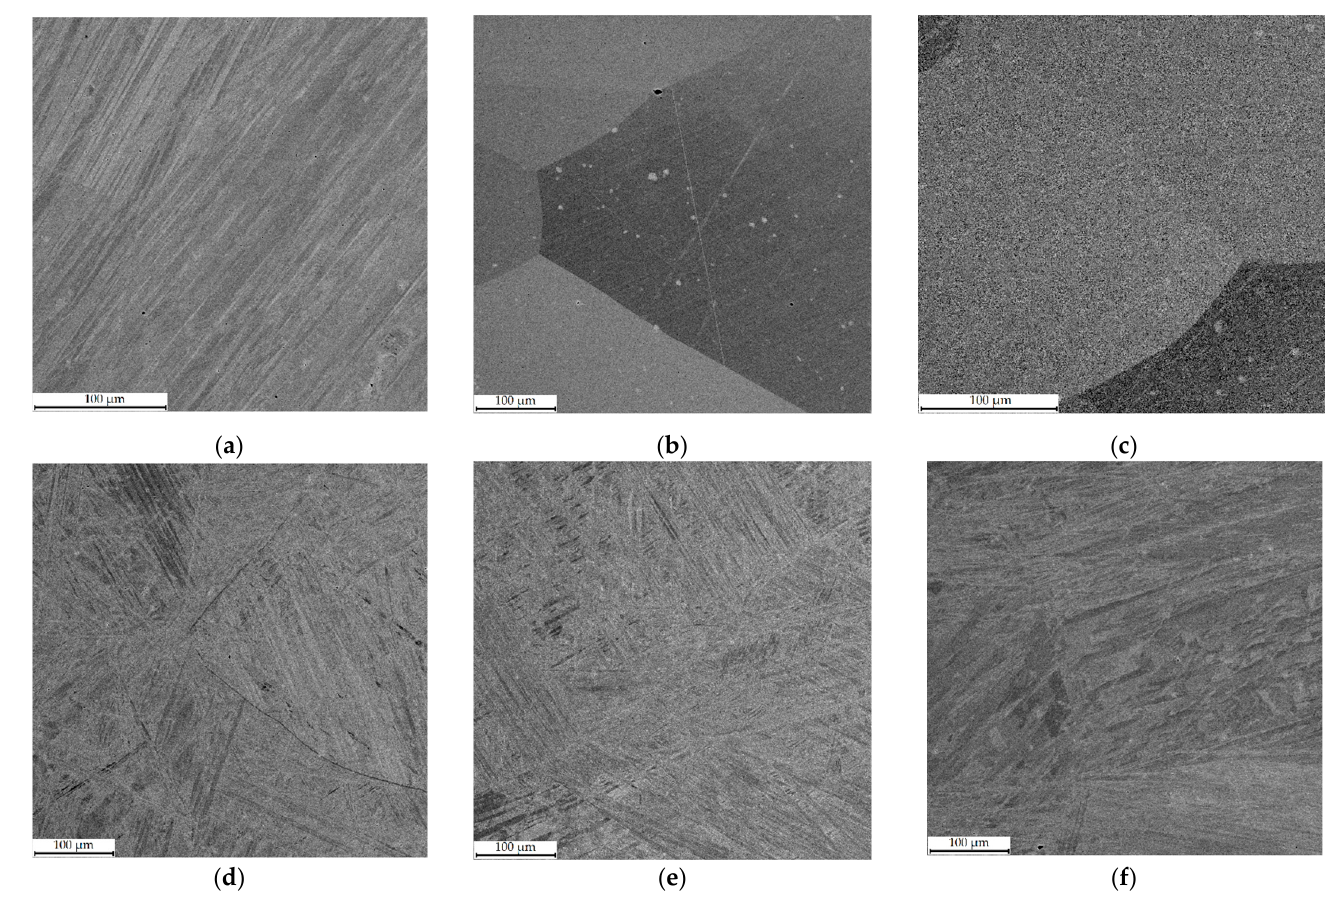
Figure 5. SEM-BSE images of annealed samples microstructure: ( a – c ) for Alloy 1, 1–3 regimes, respectively; ( d – f ) for Alloy 2, 1–3 regimes, respectively.